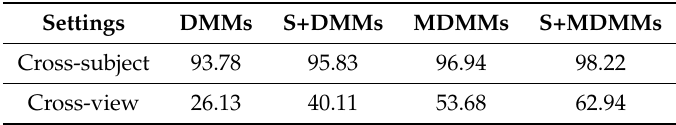
Table 3. A comparison between DMMs and MDMMs concatenated with spatial information (depth and RGB) in terms of the NUCLA dataset.